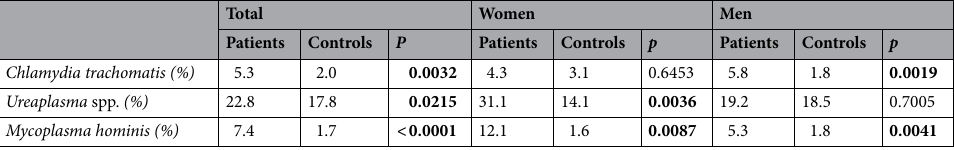
Table 1. Prevalence of urogenital infections in patients with primary couple’s infertility and control individuals. Chi-square test. A * p < 0.05 was considered statistically significant. Bold p numbers mean those which are statistically significant (<0.05).